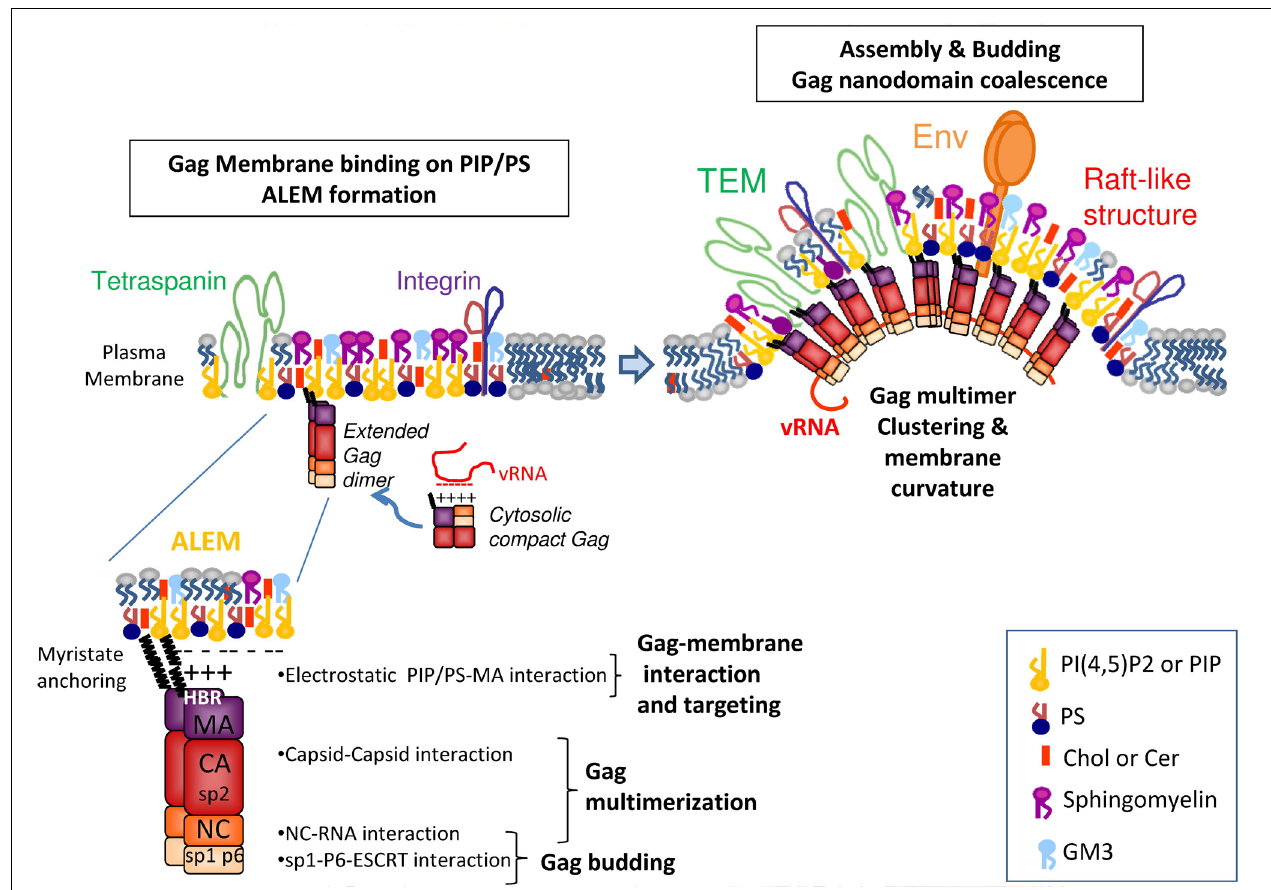
leaflet of the PM and its myristate anchors the lipid bilayer. The MA domain of Gag can recruit several PI(4,5)P 2 , and PS, thanks to its basic residues. This should allow the recruitment of other Gag molecules due to Gag electrostatic membrane interaction concomitant with Gag multimerisation, via CA, and NC on the viral RNA. This process should trigger the formation of ALEM (acidic lipid enriched microdomains) in the cell membrane. These ALEM containing Gag could now join together to create higher ordered microdomains of Gag and/or microdomains containing other proteins such as Env, or tetraspanins, integrins or other cell factors found in the viral envelope. The coalescence of these microdomains containing several Gag multimers creates the HIV assembly